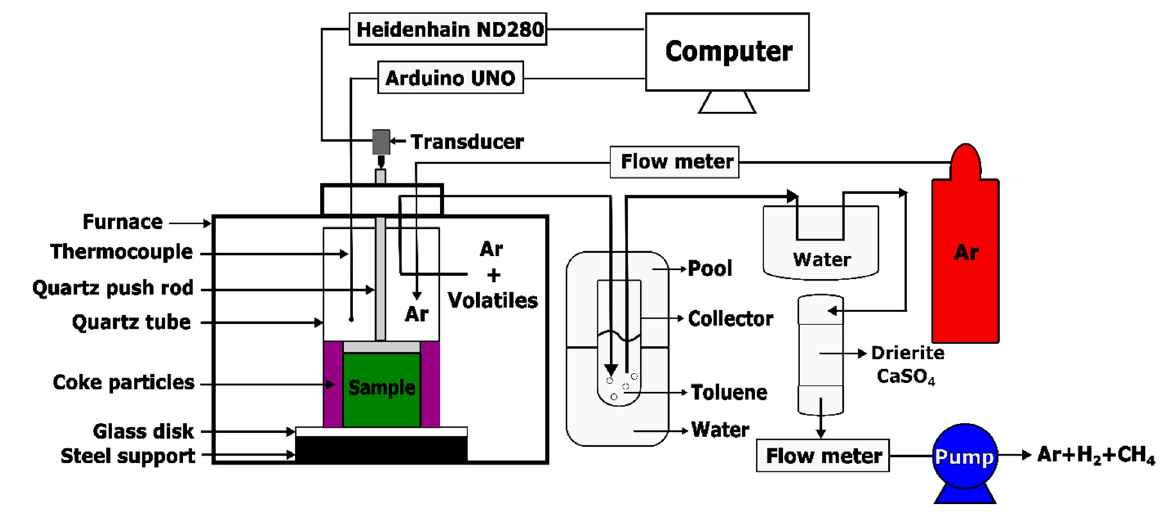
Figure 5. Schematic representation of dilatometry set-up.